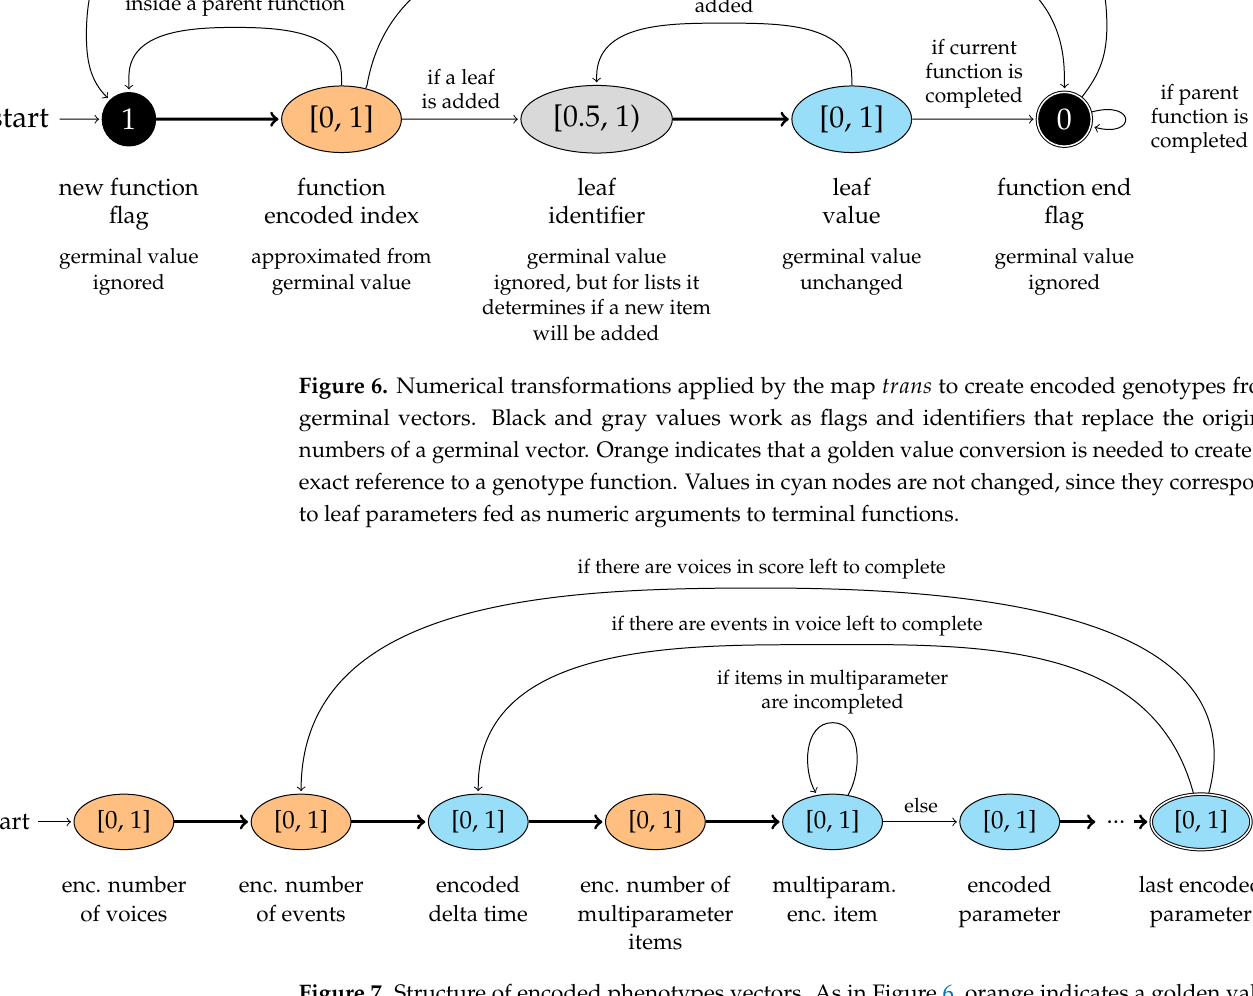
Figure 7. Structure of encoded phenotypes vectors. As in Figure 6, orange indicates a golden value conversion. Encoded phenotypes use golden values to indicate the total number of voices, total events within a voice, and total items within an event